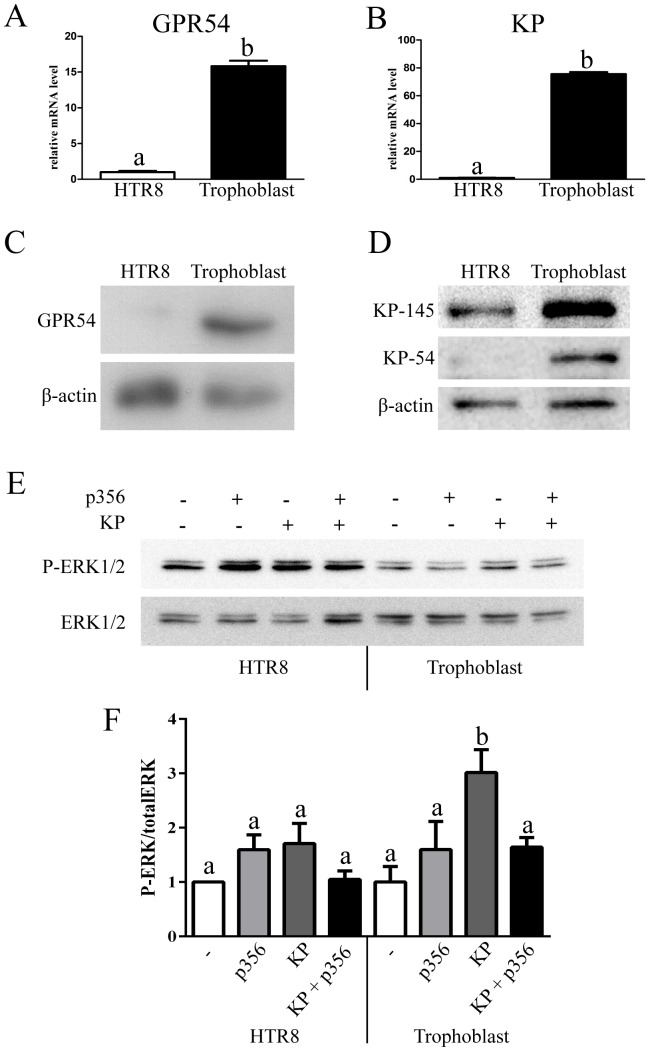
Expression of GPR54 and KP and KP induction of ERK in primary trophoblast cells.Relative mRNA expression levels of GPR54 (A) and KP (B) in HTR8 cells (white bars) and trophoblast cells (black bars). Protein expression of GPR54 (C) and KP-145 and KP-54 (D) in HTR8 cells and trophoblast cells. β-actin was used as a loading control. (E) HTR8 and trophoblast cells were treated for 10 min with vehicle (-), 1 µM KP antagonist (p356), 100 nM KP or both treatments (KP + p356) in combination in serum-free medium. Phospho- and total ERK1/2 protein levels were determined by Western Blot. (F) Quantification of Western Blots for phospho- and total ERK1/2 expression (n = 3). Error bars represent SEM. Statistical significance was tested by ANOVA, columns with different letters represent statistically different values, p<0.05, while same letters indicates no significant difference, p>0.05.